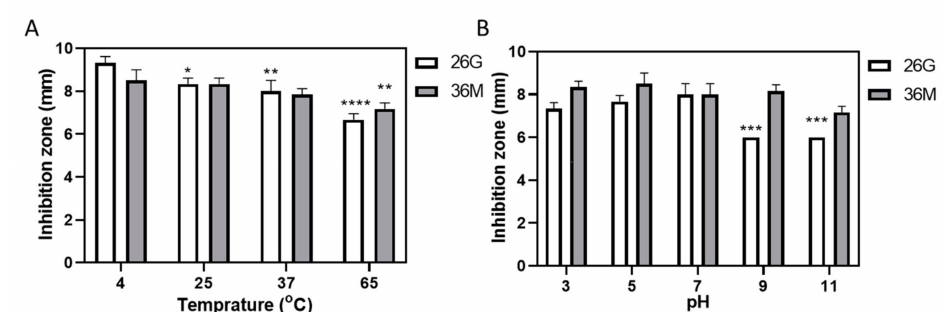
Figure 2. The 36M derivative was stable in terms of heat and pH. ( A ) Inhibition zones of 26G and 36M under different temperatures. The 26G and 36M compounds (100 mM, 10 µ L each) were pre- incubated at 4–65 ◦ C for 1 h before the agar diffusion test. ( B ) Inhibition zones of 26G and 36M were measured under different pH conditions. Both 26G and 36M (100 mM, 5 µ L each) were pre-incubated at pH 3–11 before the agar diffusion test. Tukey’s multiple comparison test, compared to 4 ◦ C or pH 7, * p < 0.05, ** p < 0.01, *** p < 0.001, and **** p <